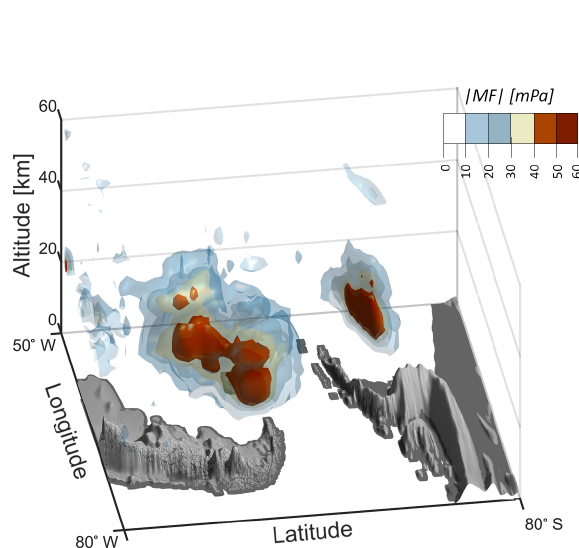
Figure 8. Meridional MF monthly means at three height levels.